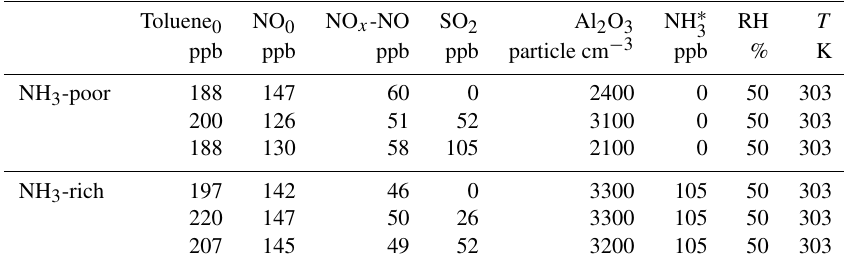
Table 2. Initial experimental conditions for toluene / NO x photooxidation in the presence of different concentrations of SO 2 and Al 2 O 3 seed particles under NH 3 -poor and NH 3 -rich conditions.